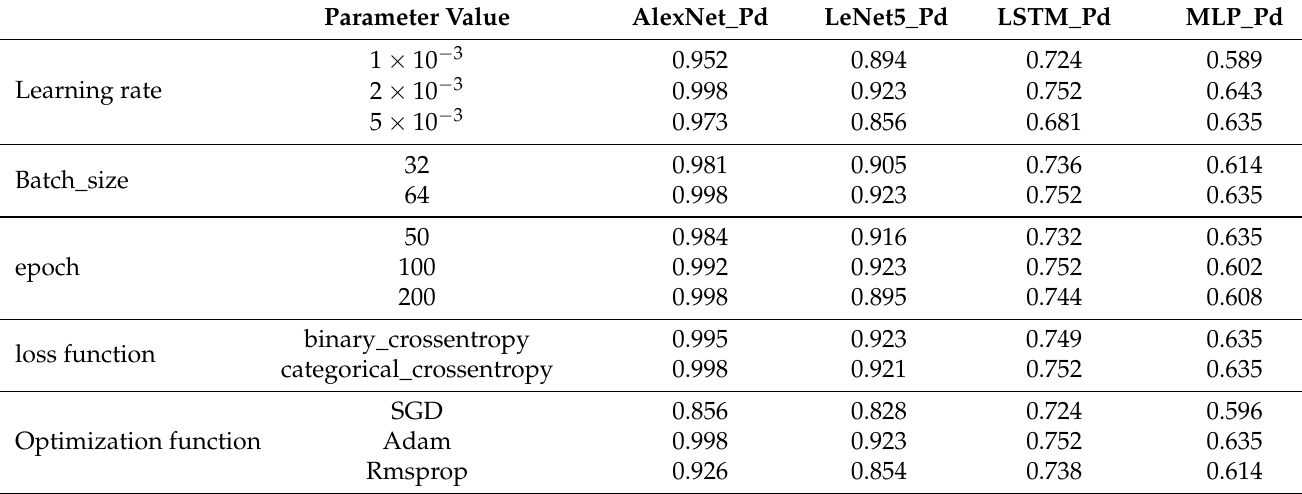
Table 2. Detection probability of model parameters and correlation functions when SNR = − 15 dB.